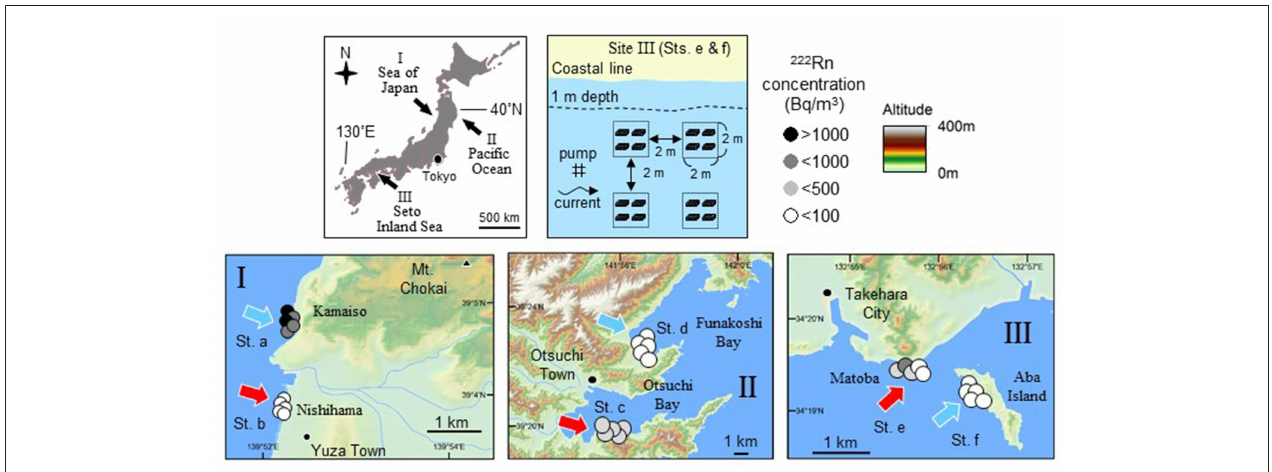
FIGURE 2 | Maps showing three survey sites where influence of SGD on trophic flow and fish feeding and growth was investigated ( top left ). The three sites ( bottom panels) were selected to cover different levels of maximum daily tidal amplitude (DTA) during spring tide period in the northwest Pacific (I: Sea of Japan with a low DTA of 0.4m, II: Pacific Ocean with an intermediate DTA of 1.5m; III: Seto Inland Sea with a high DTA of 4.0m). Production of benthic microalgae and abundances of gammarid crustacean (as dominant primary consumers and also as major prey organisms for fish) and fish were compared between two stations with different levels of 222 Rn concentration and salinity in water as an indicator for SGD (sts. a, c, and e for high SGD; sts. b, d, and f for low SGD) within each site (data for sites I, II, and III from Hata et al., 2016; Kobayashi et al., 2017; Nakajima et al., 2018, respectively). In order to evaluate the effect of SGD on fish feeding and growth, a cage experiment for 2 weeks was conducted using juvenile marbled sole Pseudopleuronectes yokohamae at site III. Physical and biological environmental conditions and stomach contents and growth rate of the juveniles were compared between the two stations (e and f). Arrangement of the experimental cages, pump, and current direction are shown ( top right ). Four experimental groups composed of four cages each are surrounded by a dotted line and depth contour of 1m at low tide is indicated by a broken